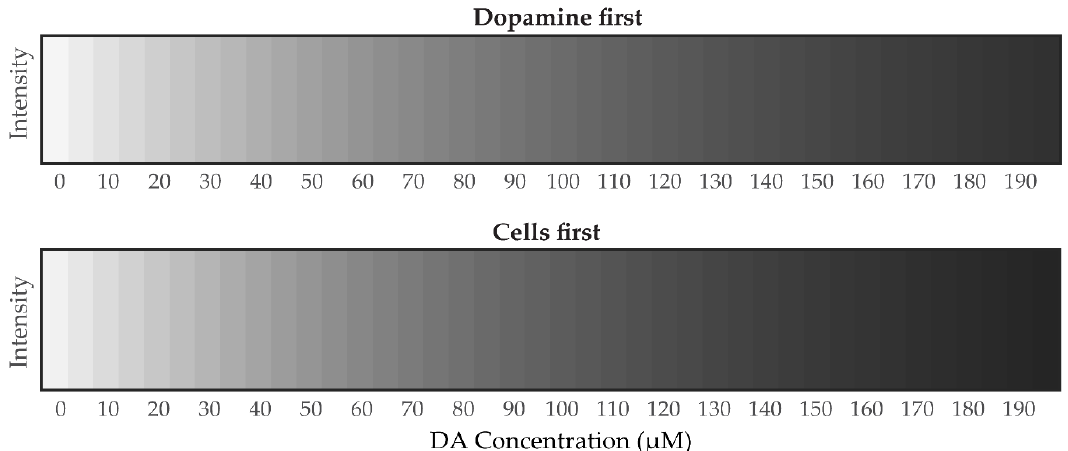
Figure 13. Projected grayscale intensities from the exponential model (6) for a wide range of dopamine concentrations (incremented by 5 µM) for both experiments: dopamine first ( top panel) and cells first ( bottom panel).